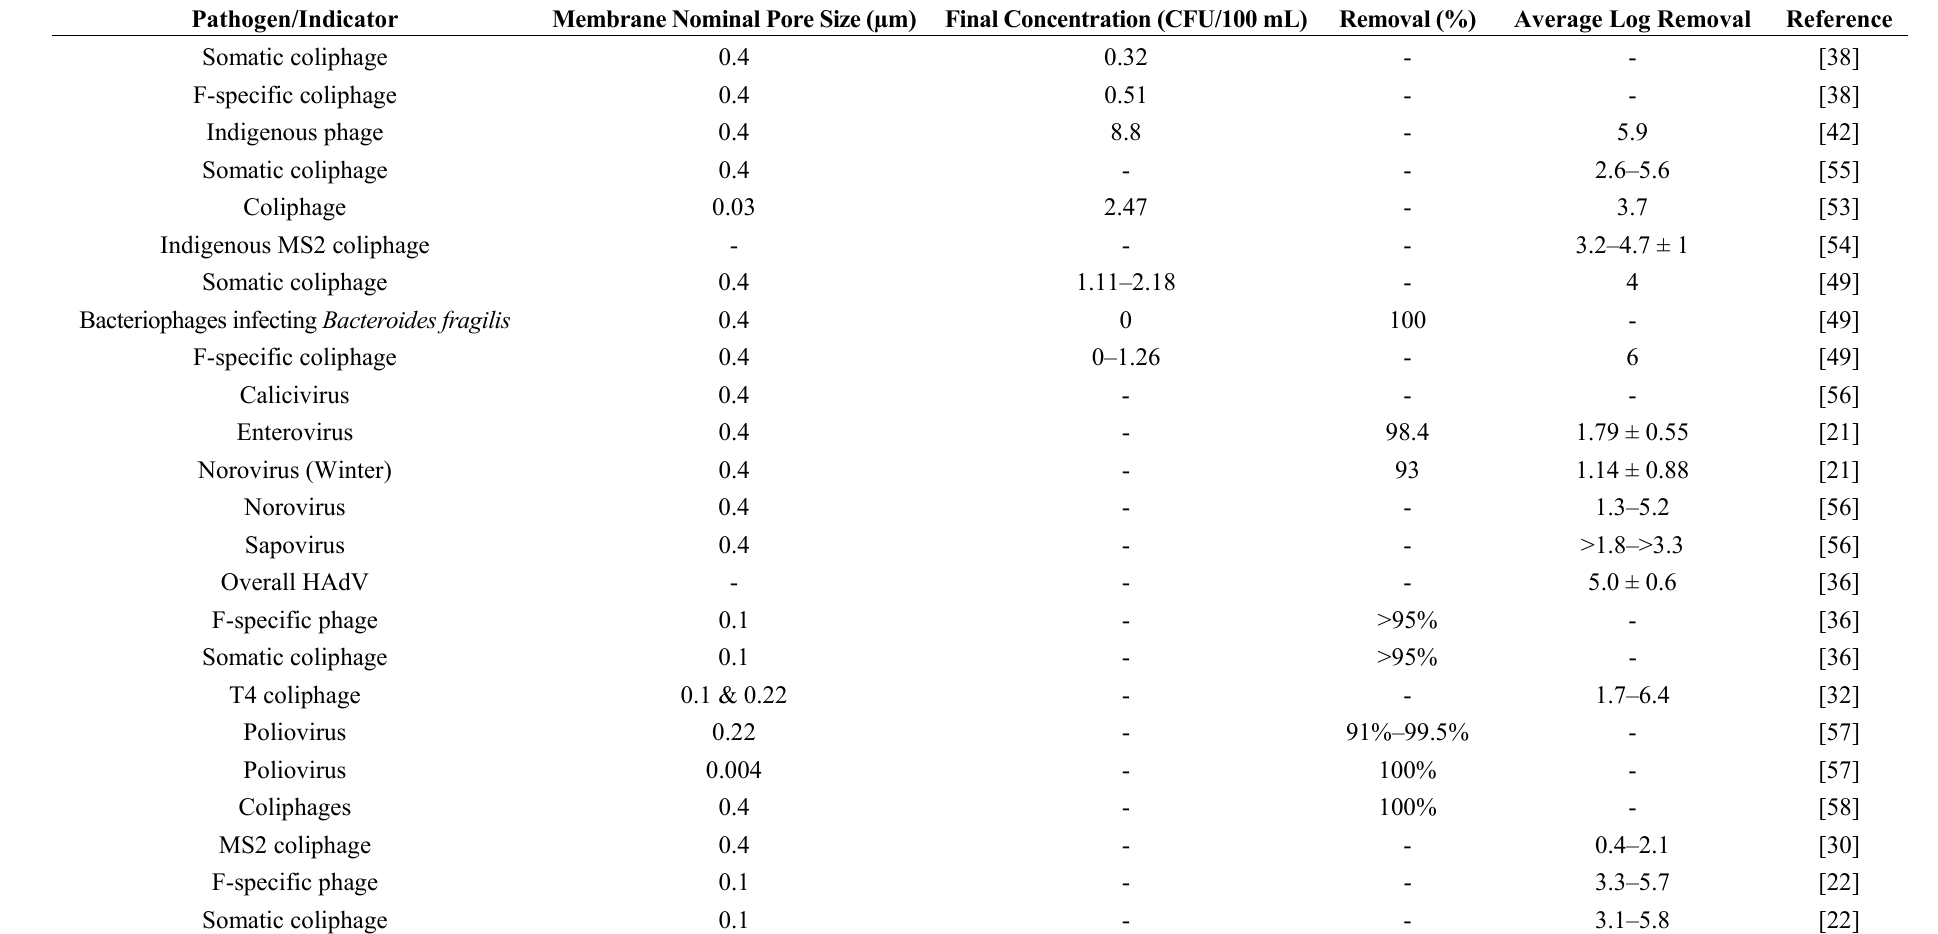
Table 3. Indicator virus removal by